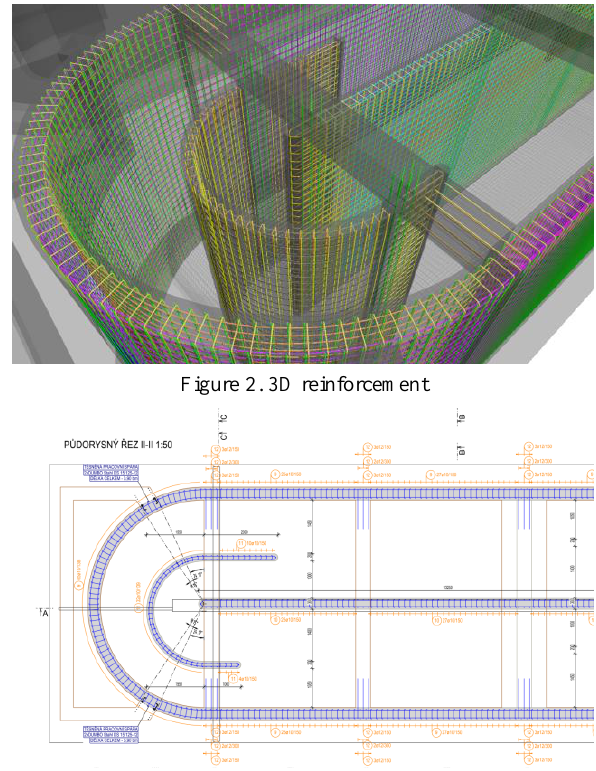
Figure 2. 3D reinforcement